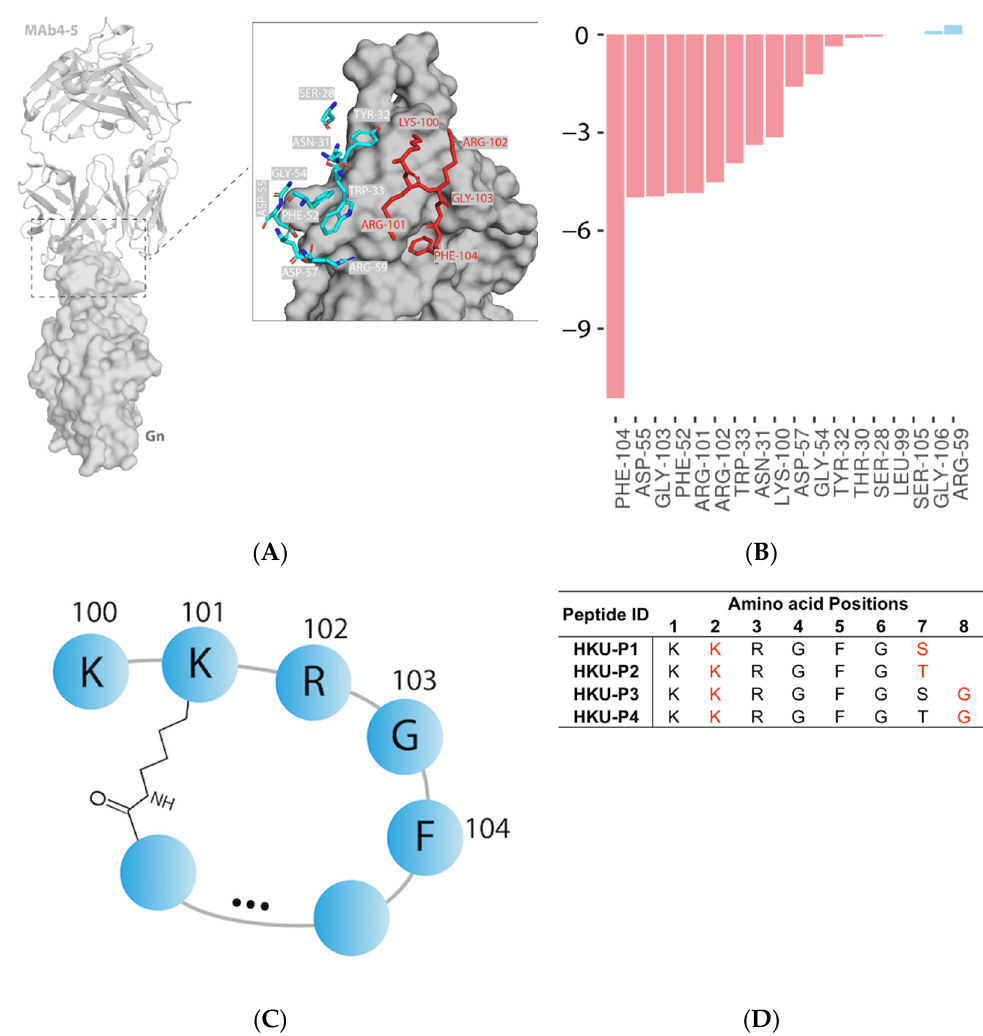
Figure 1. Antibody-based cyclic peptide design strategy. ( A ) Structural representation of MAb 4-5 (cartoon) and SFTSV Gn (surface) complex (PDB code: 5Y11). Interface residues of MAb 4-5 within 4.0 Å of SFTSV Gn in protein–protein interaction are represented by sticks. The pentapeptide selected for extension and cyclization are highlighted in red. ( B ) Residue-wise energy breakdown of the SFTSV Gn-MAb binding interface. Attractive and repulsive energies are shown in red and blue, respectively. ( C ) Diagram of the pentapeptide extension and cyclization. ( D ) The amino acid sequences of the four newly designed cyclic lariat peptides. The isopeptide bond-forming residues are highlighted in red.